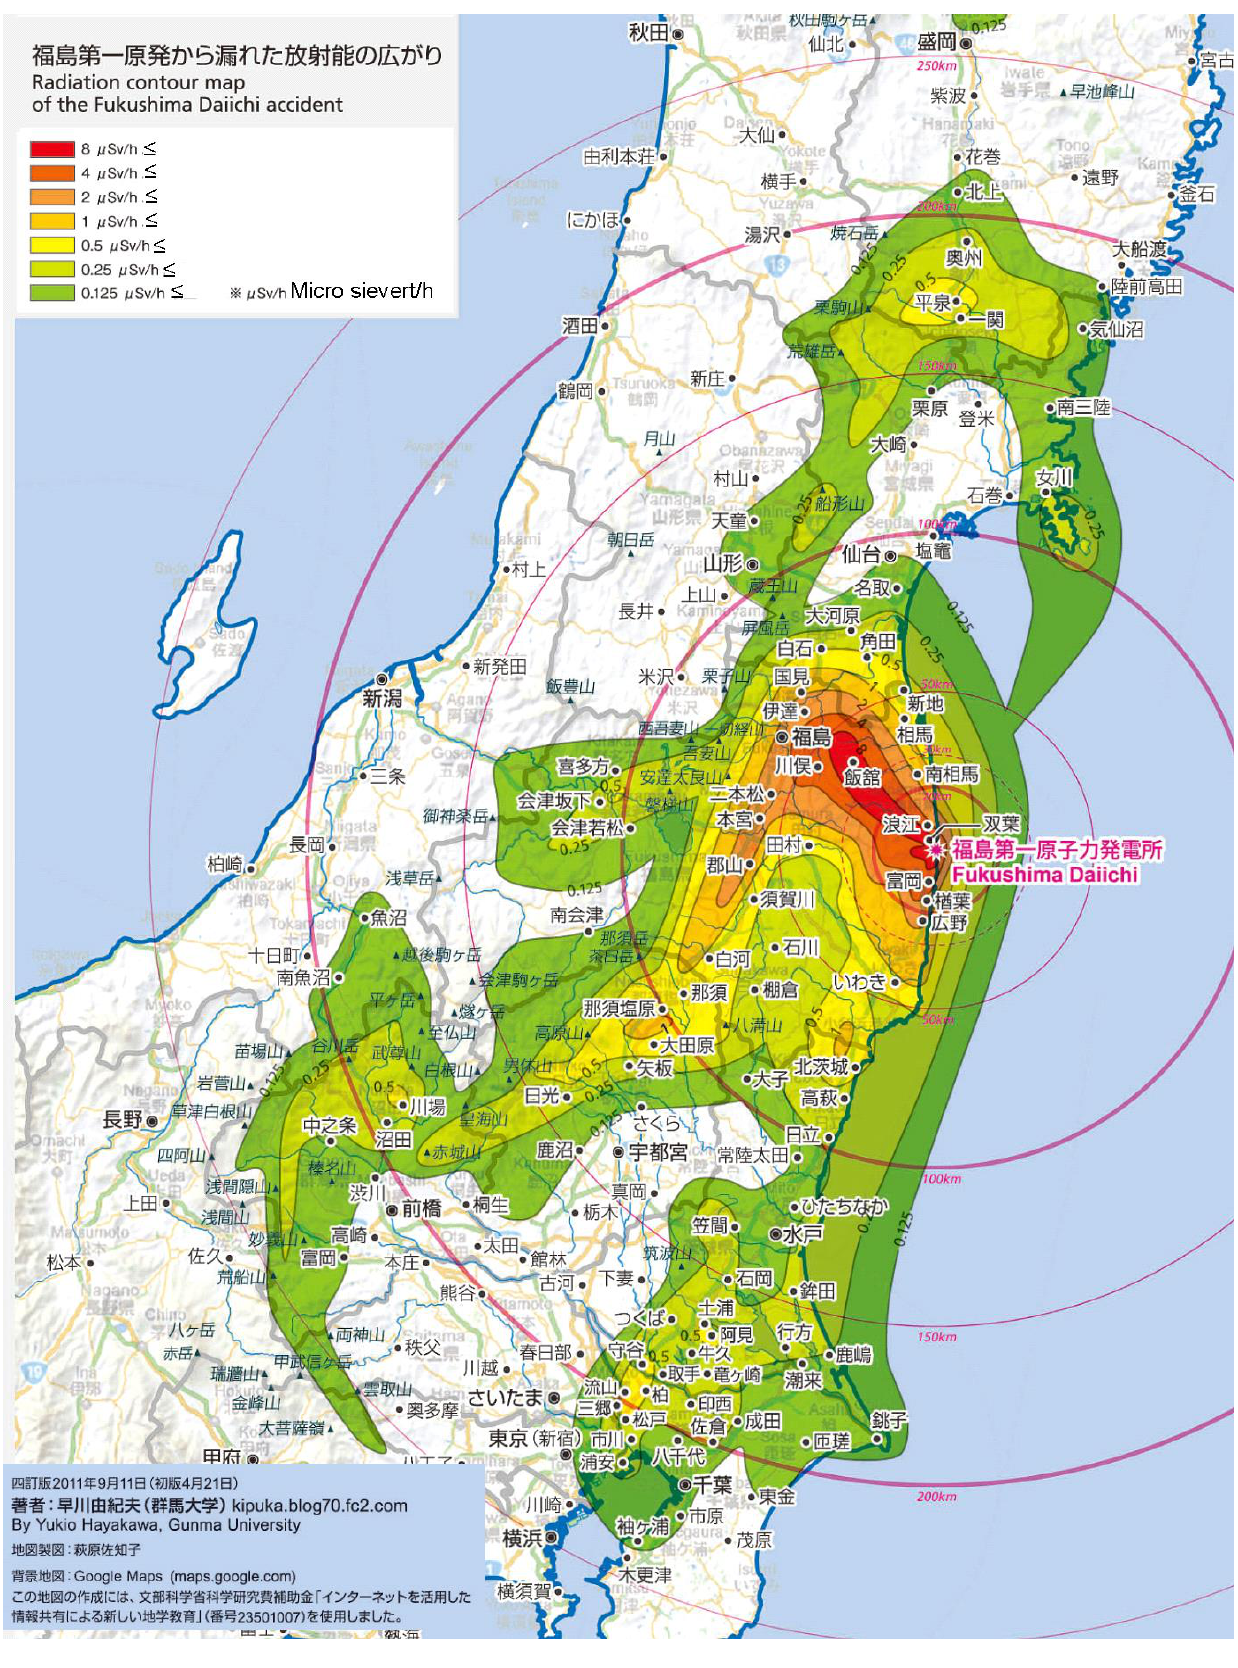
Figure 4. Radiation contour map of the Fukushima Daiichi Accident. This is arranged from the map made by Yukio Hayakawa with his permission